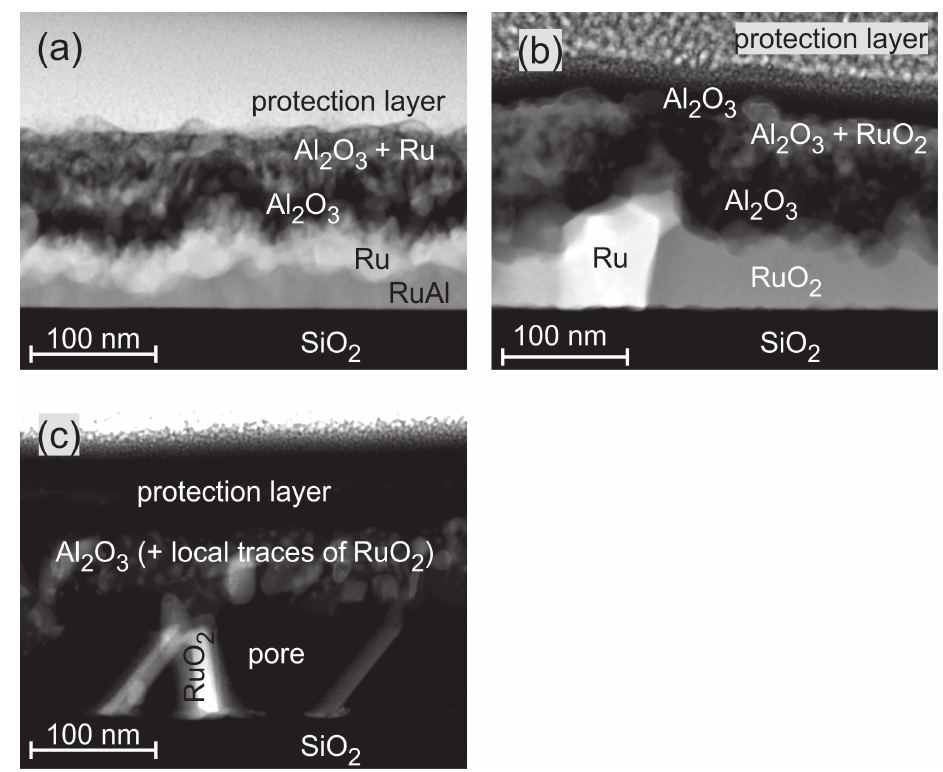
Figure 8. High-angle annular dark field scanning transmission electron microscopy (HAADF STEM) image (chemical contrast) of the Ru 50 Al 50 sample annealed at ( a ) 600 ◦ C; ( b ) 800 ◦ C; and ( c ) 900 ◦ C for 10 h under air